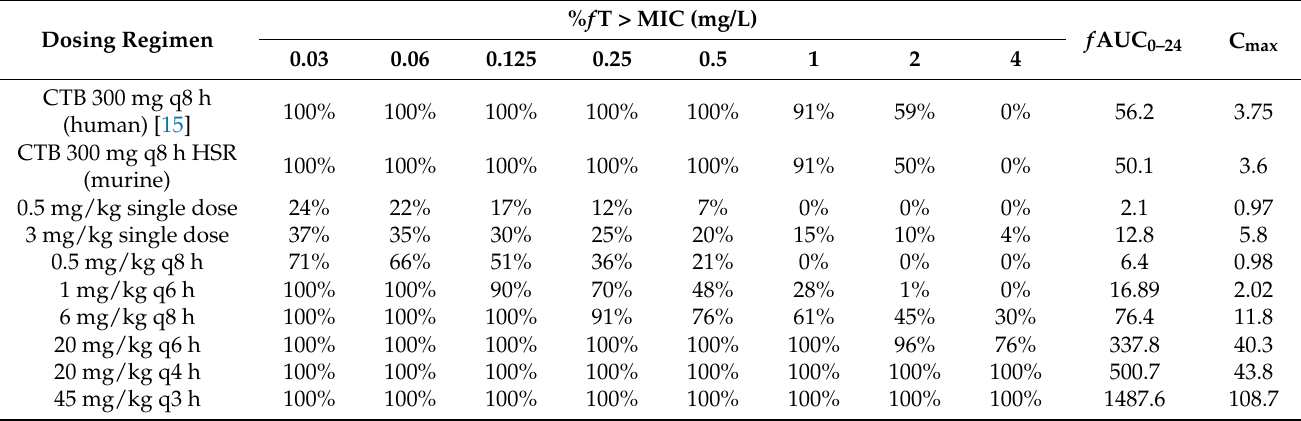
Table 2. Comparison of the % f T > MIC values achieved with ceftibuten regimens at different MICs in humans and the murine thigh infection model. Dosing